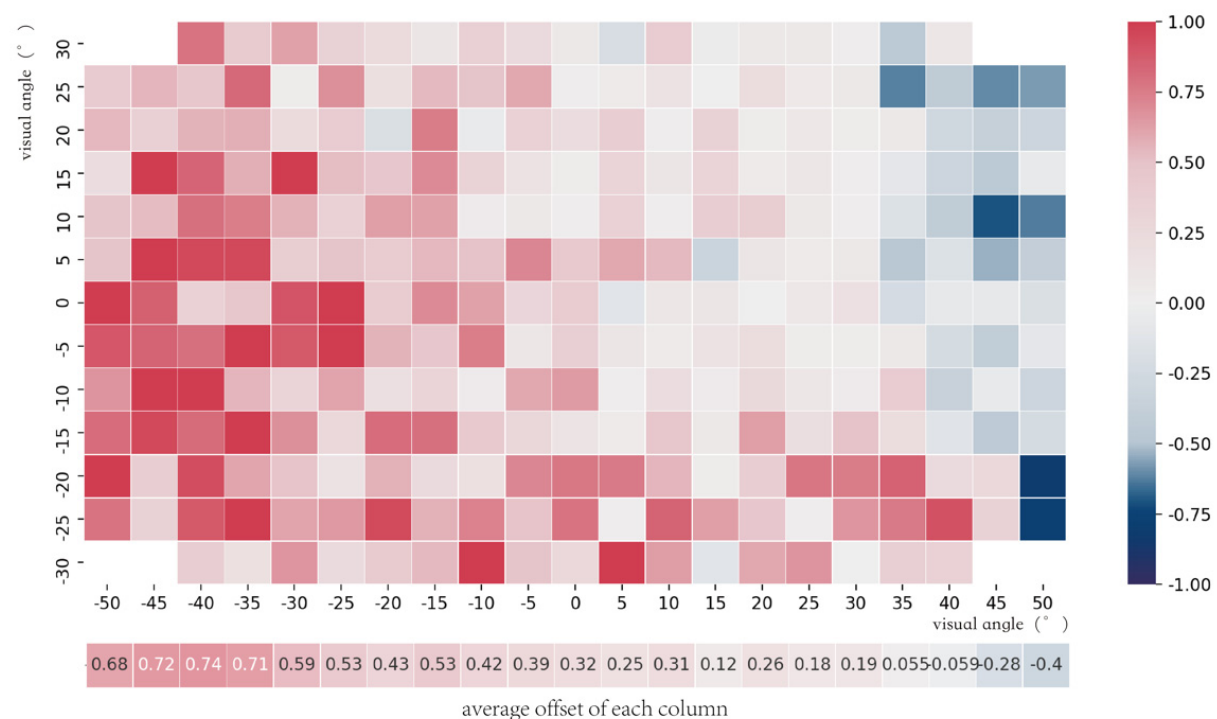
sponding grid, with blue indicating a negative offset and red indicating a positive offset. The darker the color of the grid, the larger the target click offset at this position. A heat map shows the horizontal offset in Figure 8.